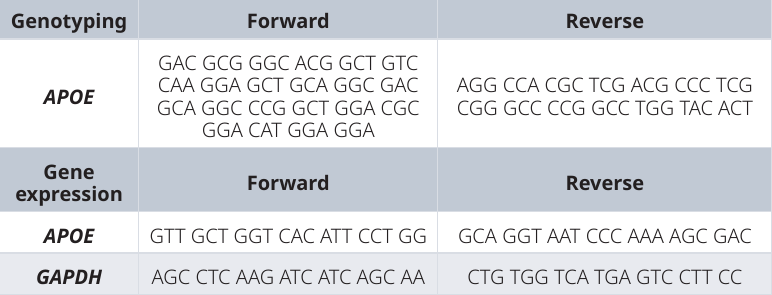
Table 2. Sequence of primers used in this study.